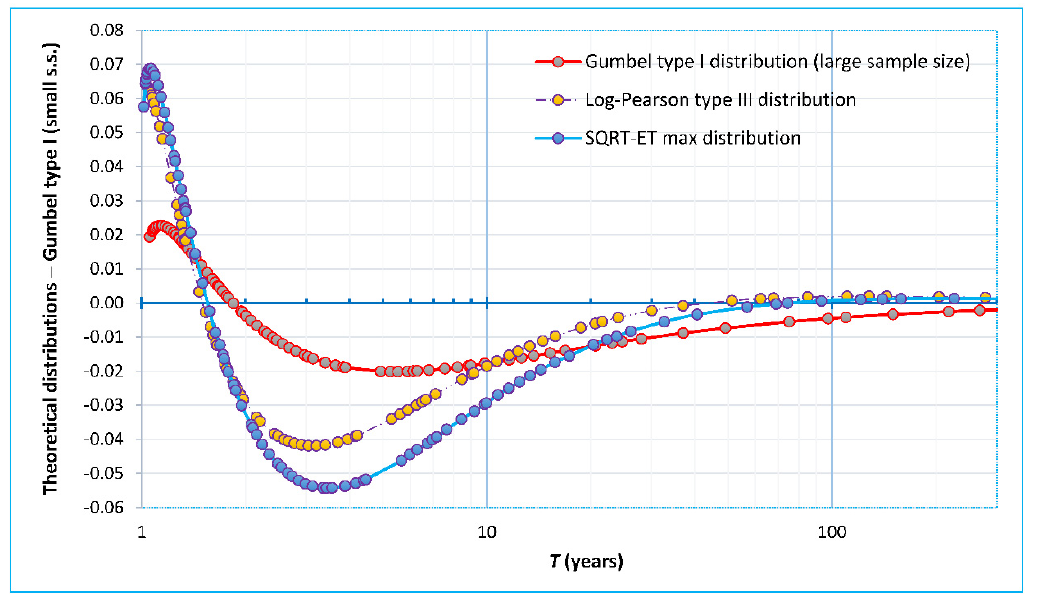
Figure 10. Differences between theoretical distributions with respect to Gumbel type I with a small sample size (small s.s.), as a reference, against return period.